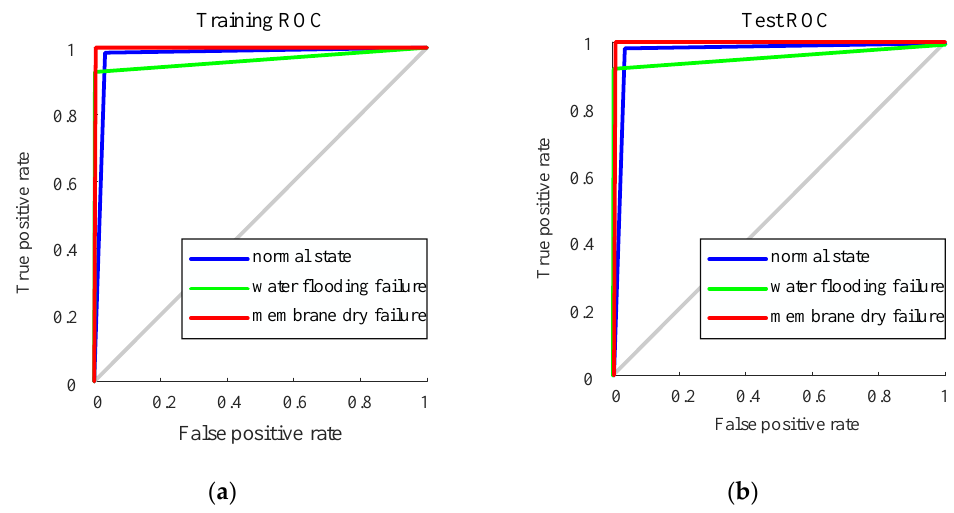
Figure 10. The receiver operating characteristic (ROC) curve of the KPCA-LVQNN for training and test samples. ( a ) Training samples; ( b ) test samples.